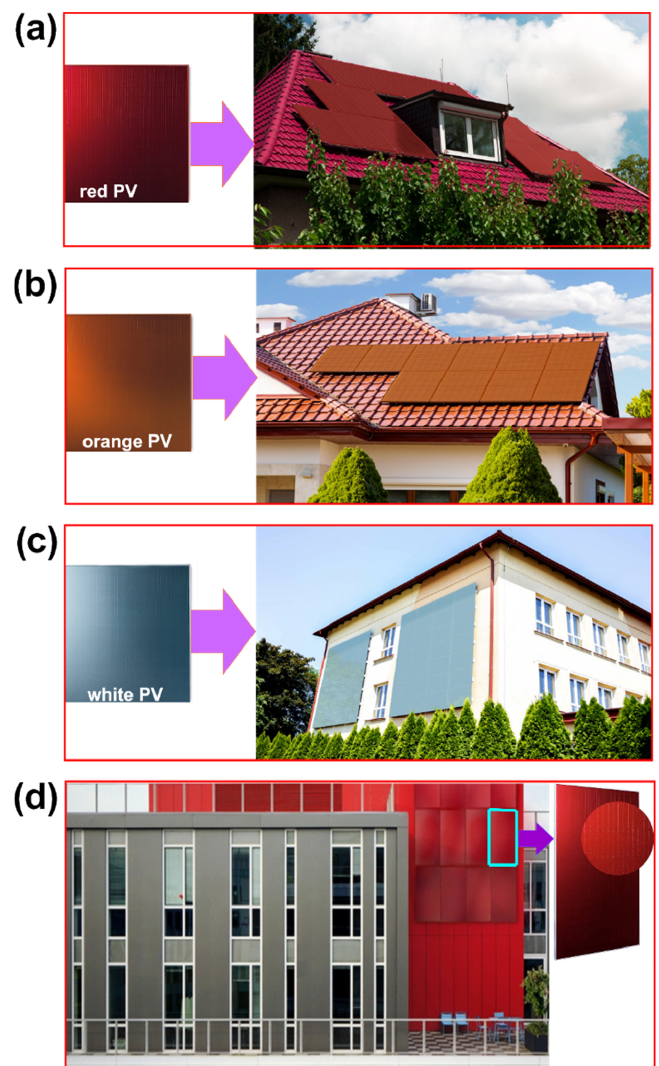
Figure 13. Colored PV modules of FuturaSun and their application (Photos by FuturaSun). ( a ) Red- colored BAPV (reproduced and modi fi ed with permission from Ref. [118]), ( b ) orange-colored BAPV (reproduced and modi fi ed with permission from [118] ), ( c ) silver-colored BAPV (reproduced and modi fi ed with permission from Ref. [118] ), and ( d ) red-colored BIPV (reproduced and modi fi ed from [119,120] with proper permission).